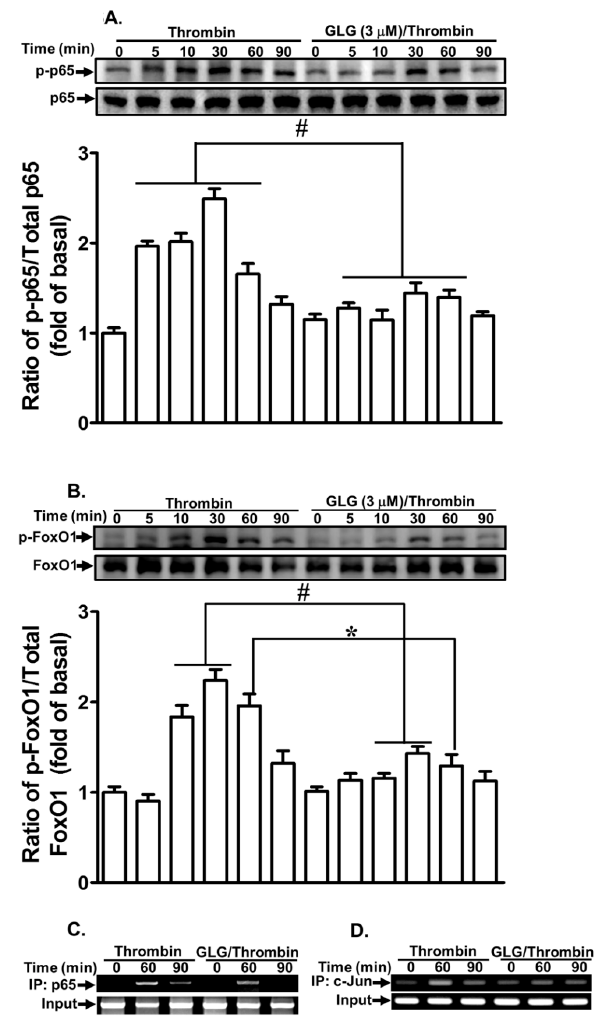
Figure 6. Galangin reduces thrombin-induced proMMP-9 expression via inhibiting nuclear factor-kappaB (NF- κ B), activator protein 1 (AP-1), and forkhead box protein O1 (FoxO1). The cells were pretreated with galangin (3 µ M) for 1 h and then challenged with thrombin (10 U/mL) for the indicated time intervals. The levels of ( A ) p65 and ( B ) FoxO1 phosphorylation and their respective protein levels were determined by western blot. ( C , D ) The cells were pretreated with/without galangin (3 µ M) for 1 h and then incubated with thrombin (10 U/mL) for the indicated time intervals, chromatin immunoprecipitation (ChIP) assay was performed by using the antibodies-p65 ( C ) and c-Jun ( D ), respectively. The data are expressed as mean ± SEM of three independent experiments. * p < 0.05; # p < 0.01, as compared with the cells exposed to thrombin